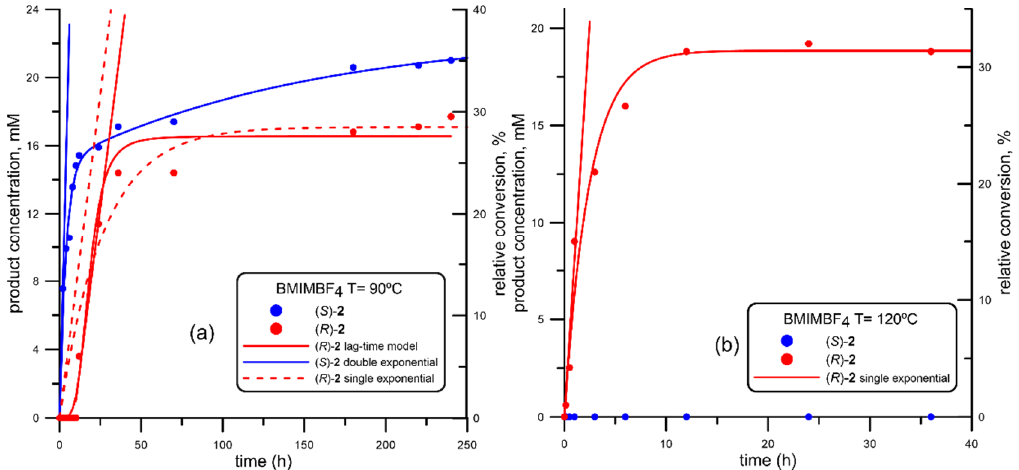
Figure 2. Progress curve of the BTL2-catalyzed production of both enantiomers of mandelic acid (( R )-acid, in red; ( S )-acid, in blue) via ethanolysis of racemic 2-(butyryloxy)-2-phenylacetic acid ( R , S )- 1 , using 1-butyl-3-methyl imidazolium tetrafluoroborate (BMIMBF 4 ) at different temperatures. ( a ) 90 °C; ( b ) 120 °C. Fitting parameters shown in Table 2, corresponding to entries #4 (BMIMBF 4 at 90 °C) and #5 (BMIMBF 4 at 120 °C).